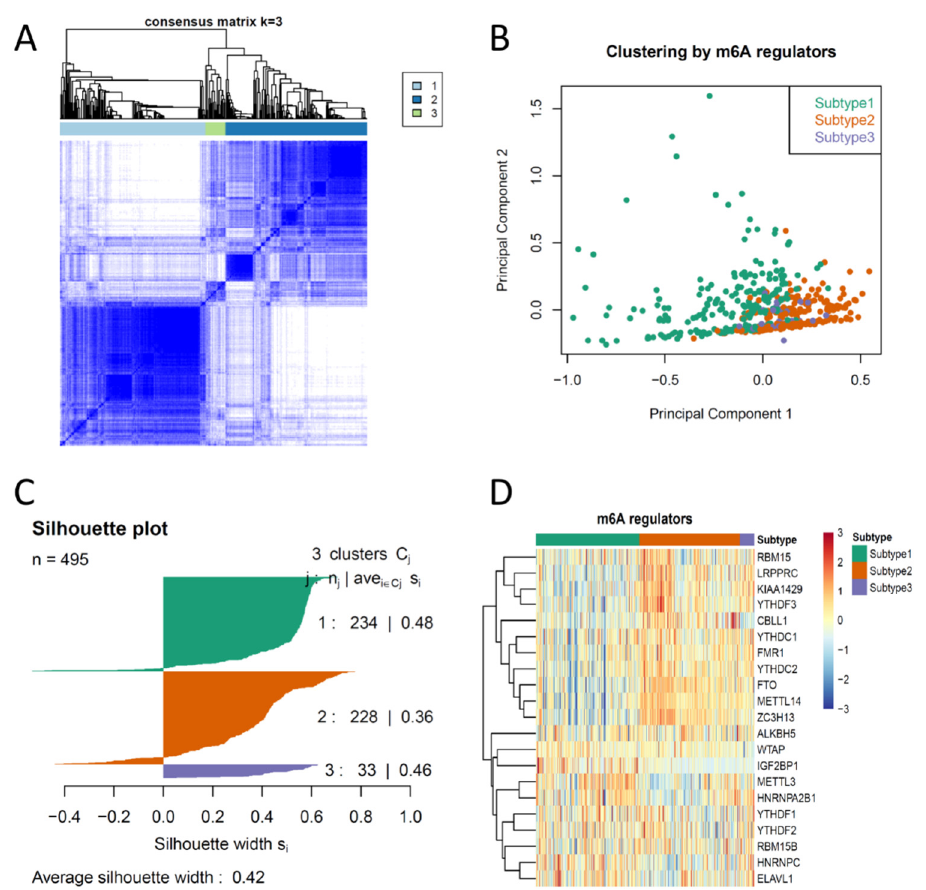
Figure 1. Consensus clustering of m 6 A regulators demonstrates three distinct subtypes in prostate cancer (PCa). ( A ) Heatmap showing the consensus matrix (k = 3) of m 6 A regulator expression. ( B ) PCA showing the clustering of PCa by m 6 A regulators. ( C ) Silhouette plot showing the similarity of samples clustered in sample subtypes. ( D ) Heatmap showing the distinct pattern of each m 6 A regulator in all 454 PCa